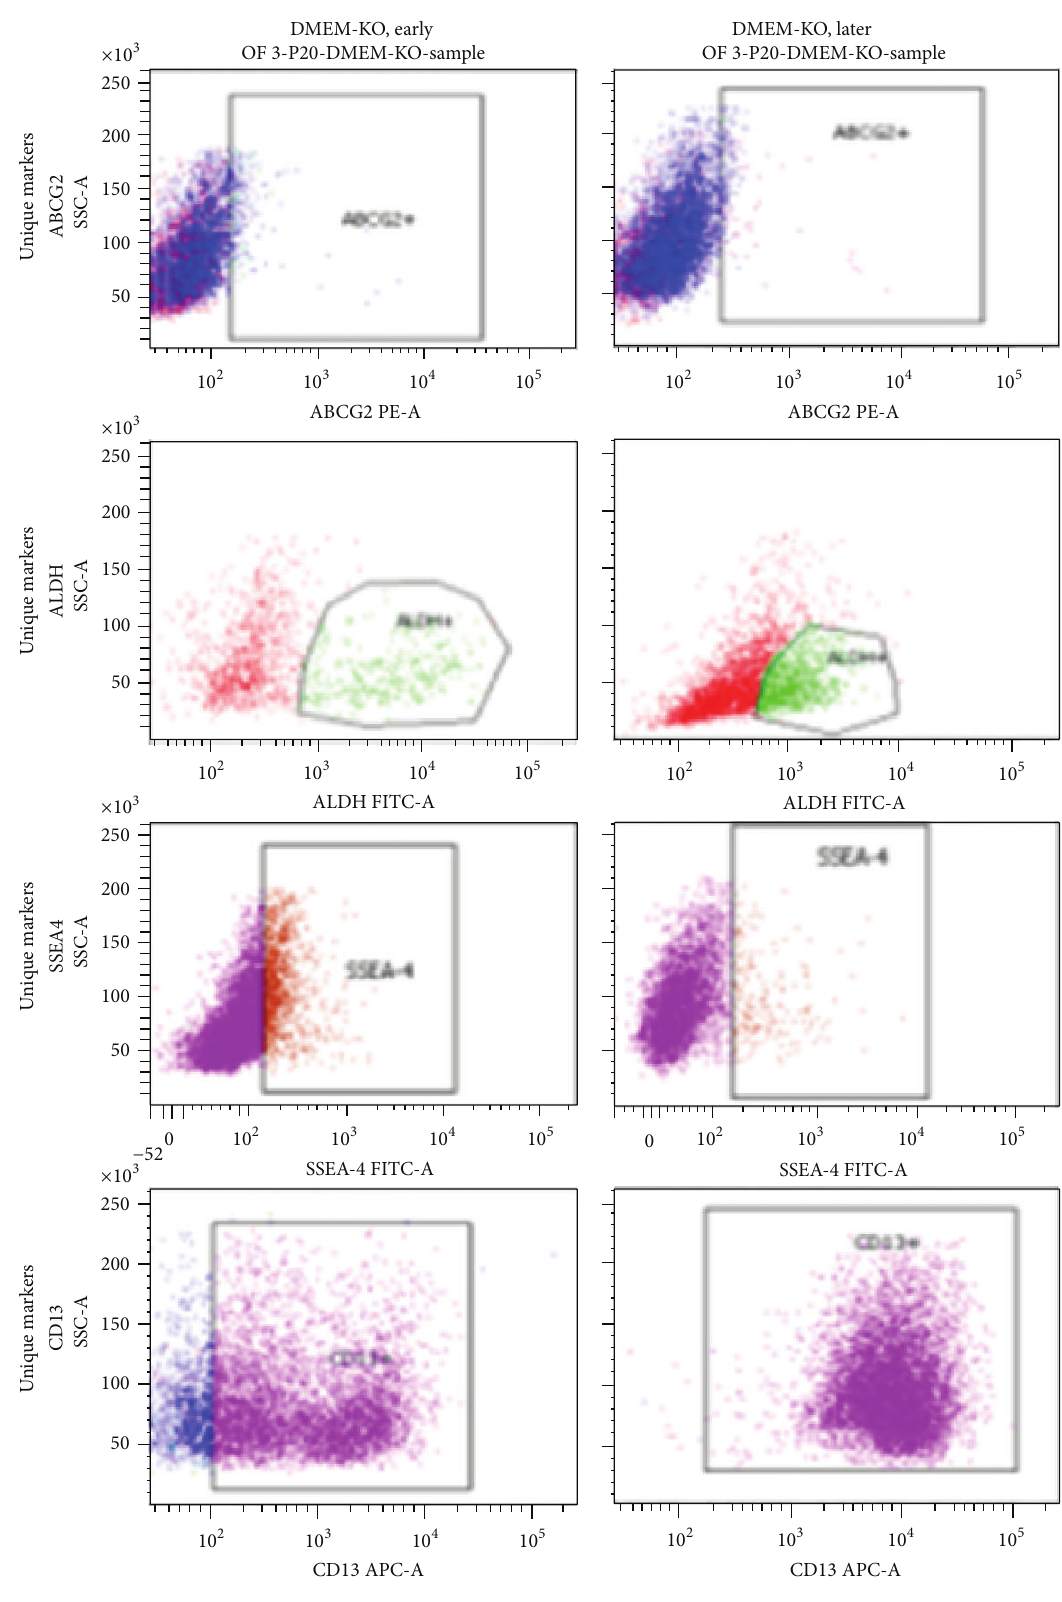
Figure 3: Flowcytometric characterization of HSC and unique markers of omentum fat derived MSC. Characterization of omentum fat derived MSC at early (P3) and late (P20) passages in DMEM-LG, Alpha-MEM, DMEM-F12, and DMEM-KO for CD34, CD45, CD133, HLA- DR, CD117, ABCG2, ALDH, SSEA4, and CD13 using